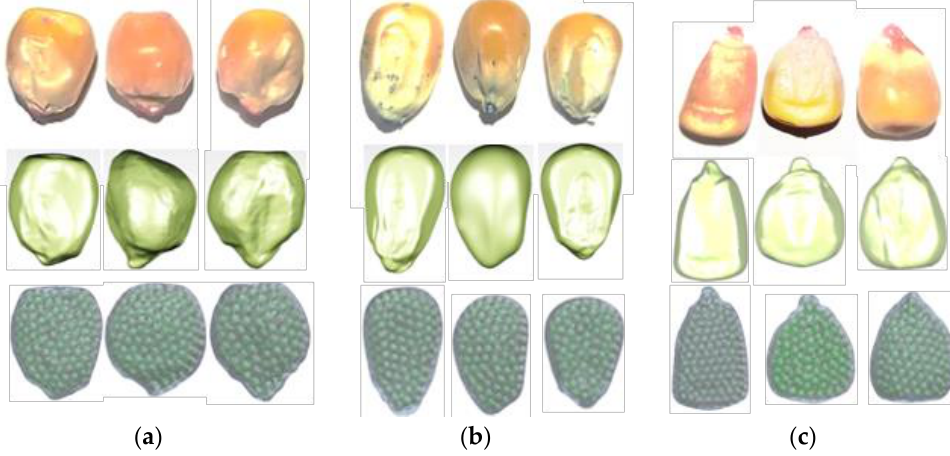
Figure 8. Simulation models of the maize seeds. ( a ) Denghai 605 variety; ( b ) Denghai 615 variety; ( c ) Nonghua 101